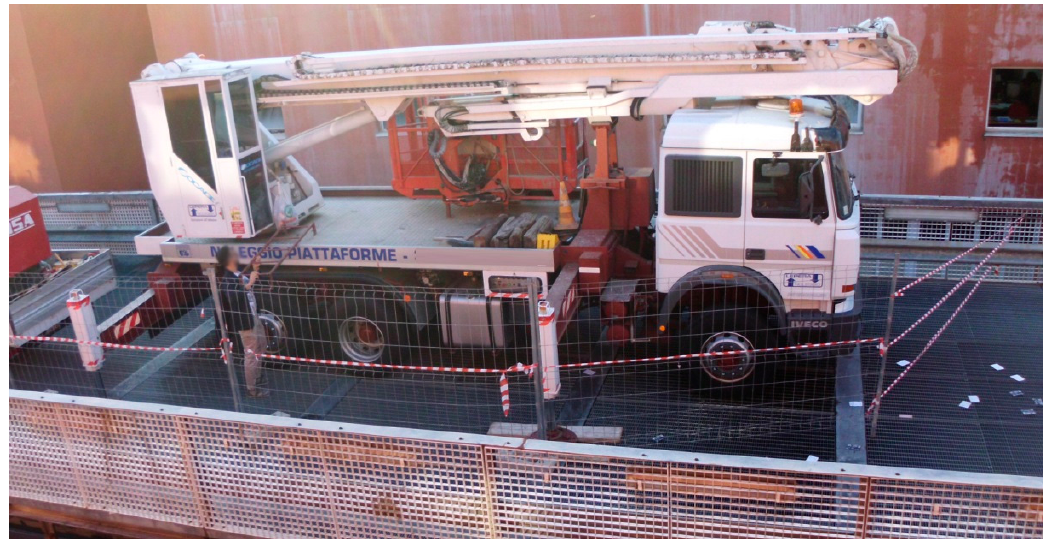
Figure 8. The truck elevator on the upper deck of the bridge.